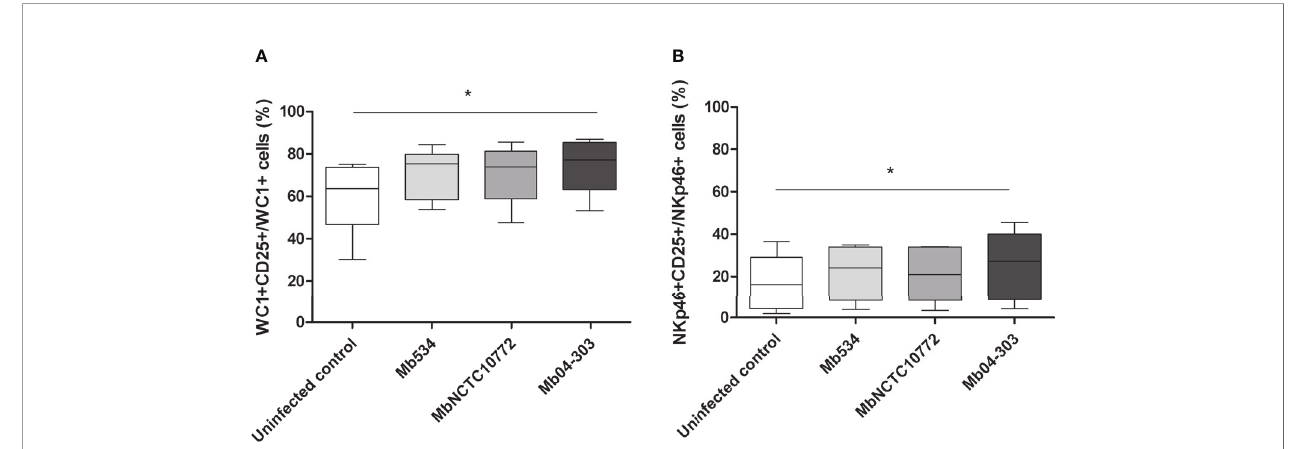
FIGURE 2 | CD25 (IL-2R) expression assessed by fl ow cytometry in infected co-cultures (MOI=1) of cells obtained from fi ve different calves (N=5). For each animal sample and condition tested a single cell well was analyzed. The results are expressed as CD25+ cells among total WC1+ (A) and NKp46+ (B) populations. Whiskers and plots indicate minimum, maximum and mean values. *p<0.05 using Friedman test with Dunn ’ s post- test for multiple comparisons.